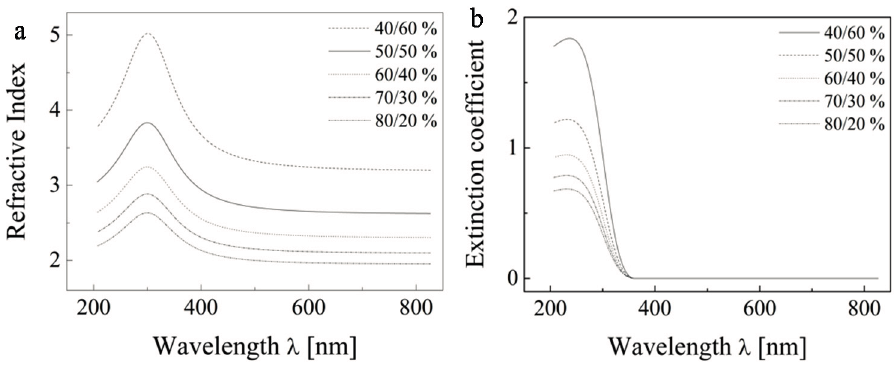
Figure 9. The dispersion dependence of the refractive index ( a ) and extinction coefficient ( b ) of the pure TiO 2 solid fraction